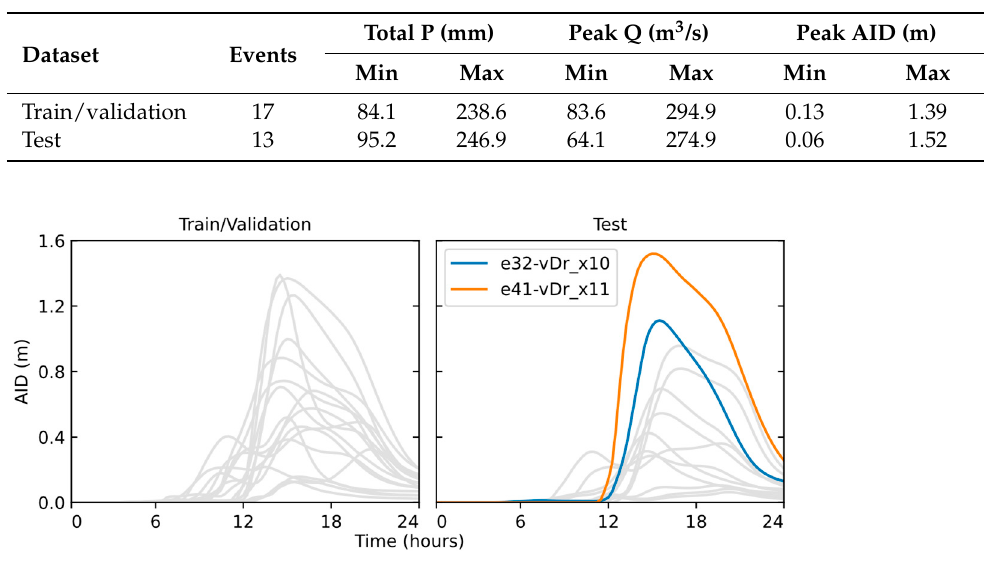
Figure 5. AID timeseries of the rainfall-runoff events selected to compose the train/validation ( left ) and test ( right ) datasets. Highlighted timeseries are from events selected as study cases.